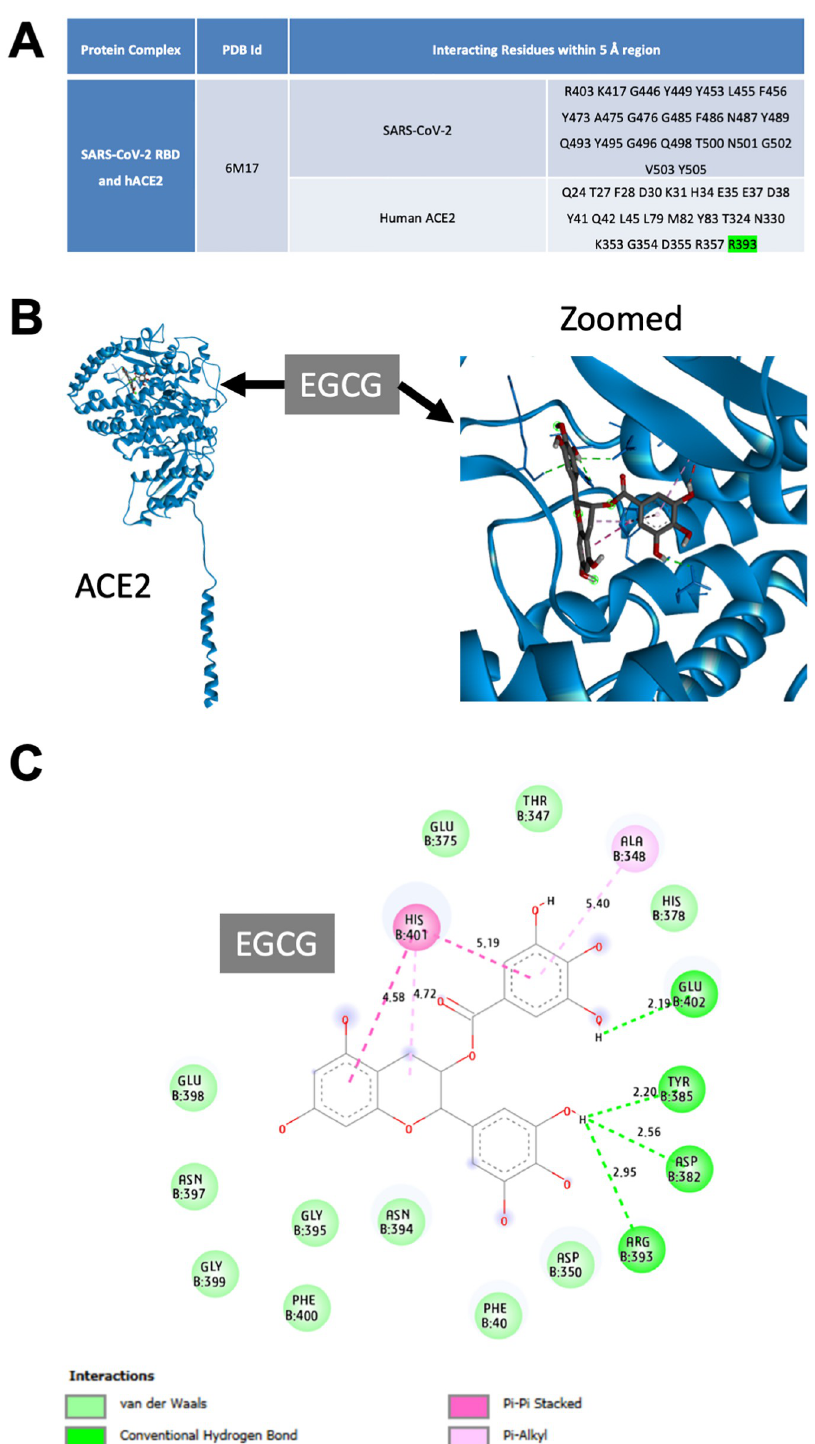
Fig 3. Docking interaction of epigallocatechin gallate (EGCG) with human angiotensin-converting enzyme 2 (ACE2). ( A ) Interacting residues determined within a 5- Å region at the interface of the severe acute respiratory syndrome coronavirus 2 (SARS-CoV-2) receptor-binding domain (RBD) and human ACE2 from their crystal structure (6M17). ( B & C ) Molecular docking of human ACE2 and EGCG. ( B ) Three-dimensional representation of EGCG binding with the human ACE2 peptidase domain (left) and magnified image (right). ( C ) Two-dimensional